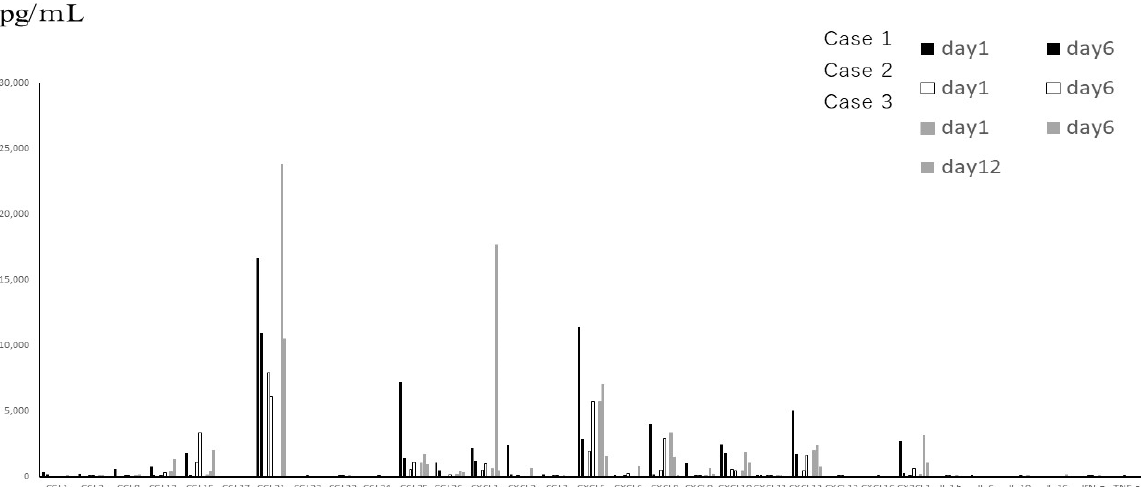
Figure 3. Main cytokines, including inflammatory cytokines expressed in TAF, which were obtained from 3 patients with severe disease, on different days.